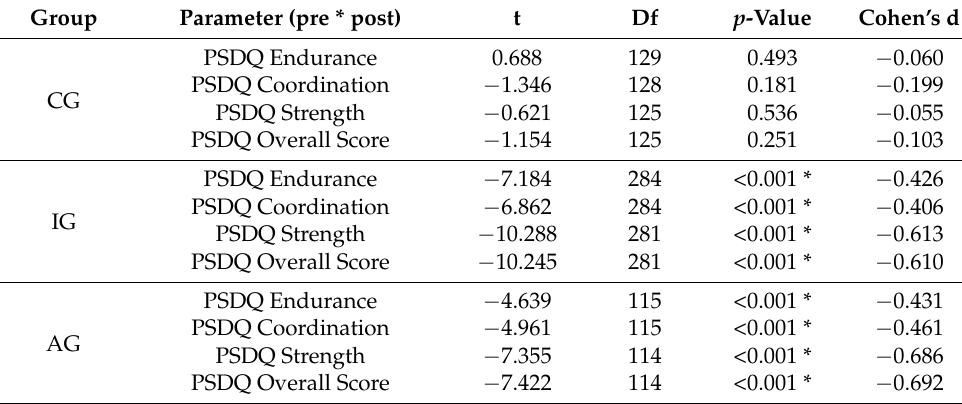
Figure 4. Results for the single dimensions ( a – c ) and total score ( d ) of the Physical Self-Description Questionnaire pre- and post-intervention for all three groups. CG = control group; IG = intervention group without activity tracker; AG = activity tracker group receiving the same web-based intervention as the IG. Table 3. Paired sample t-test for time effect of PSDQ subtests and overall score between pre- and post-test measurements. CG = control group; IG = intervention group without activity tracker; AG = activity tracker group receiving the same web-based intervention as the IG. Negative values indicate a lower value at pre- than at post-test